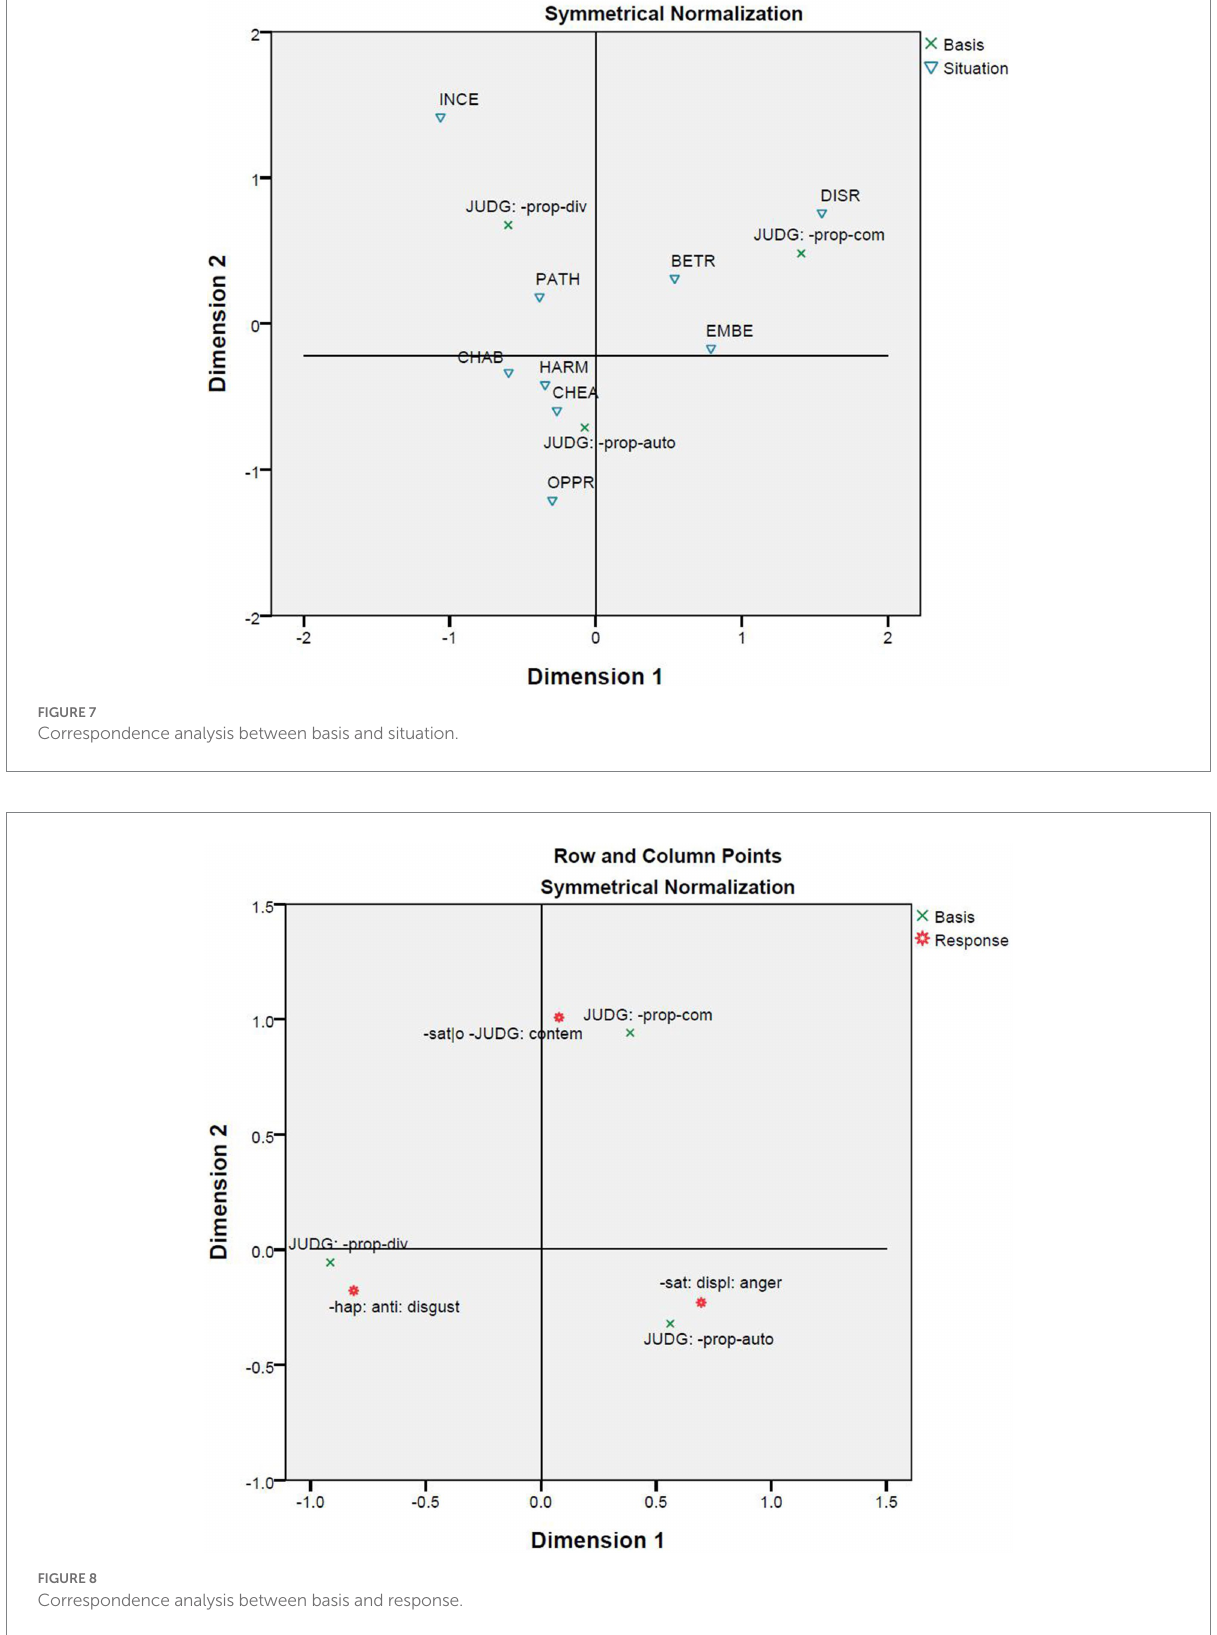
FIGURE 8 Correspondence analysis between basis and